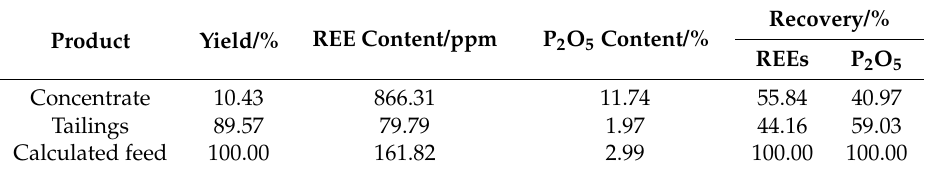
Table 1. Results of shaking table separation.